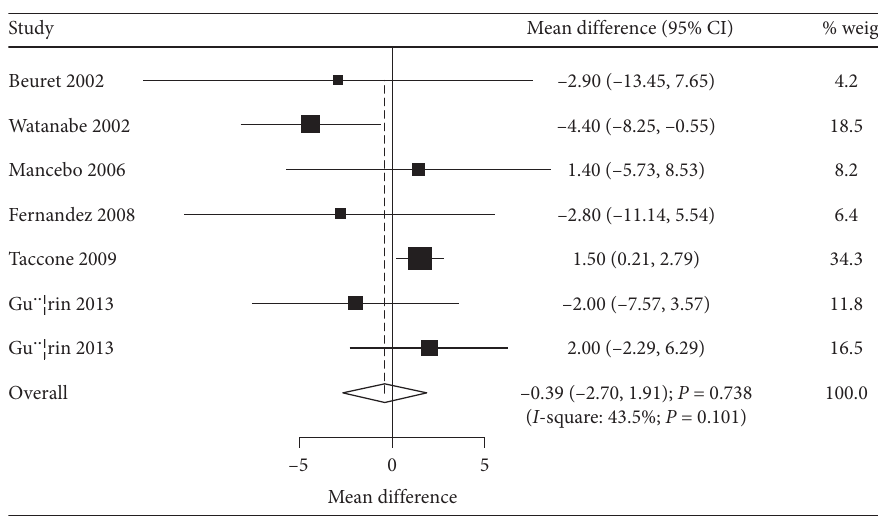
Figure 4: Prone versus supine position ventilation on ICU stays.